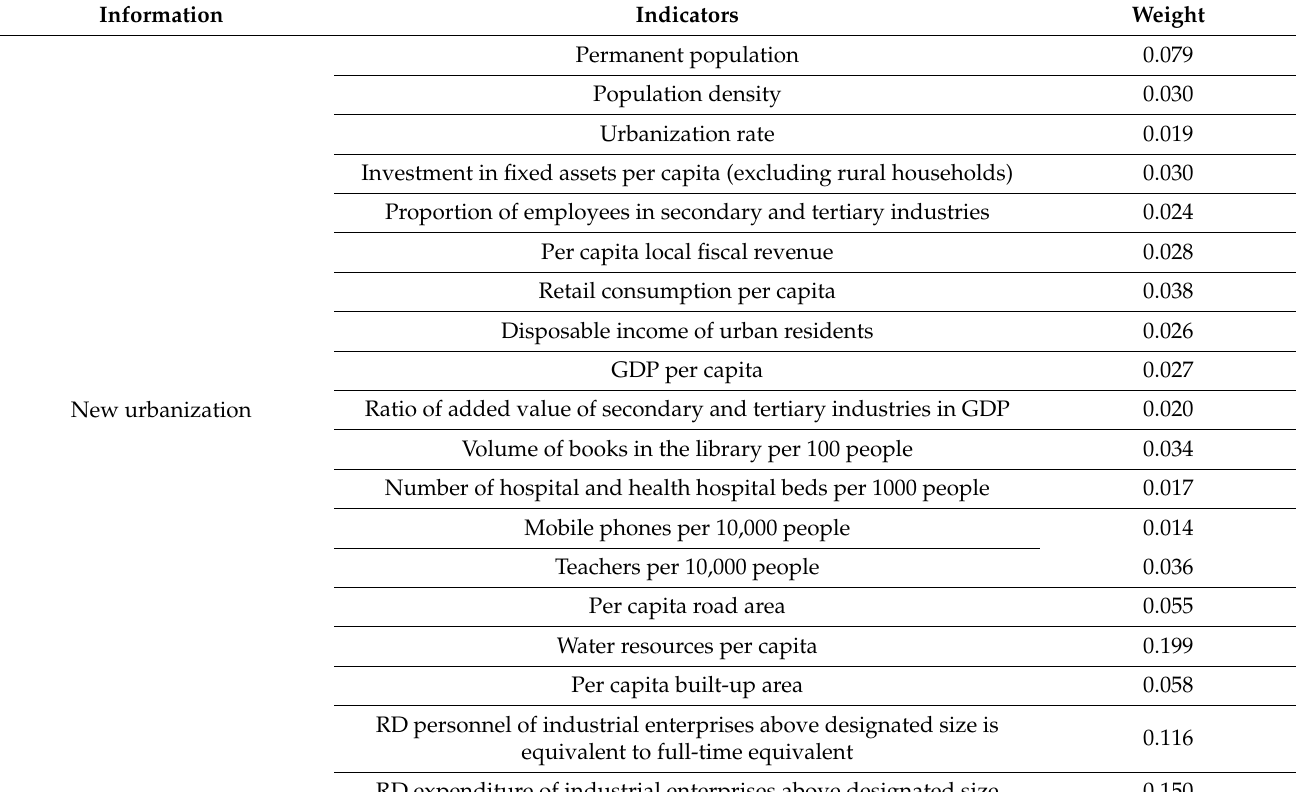
Table 3. New urbanization and ecological carrying capacity weight